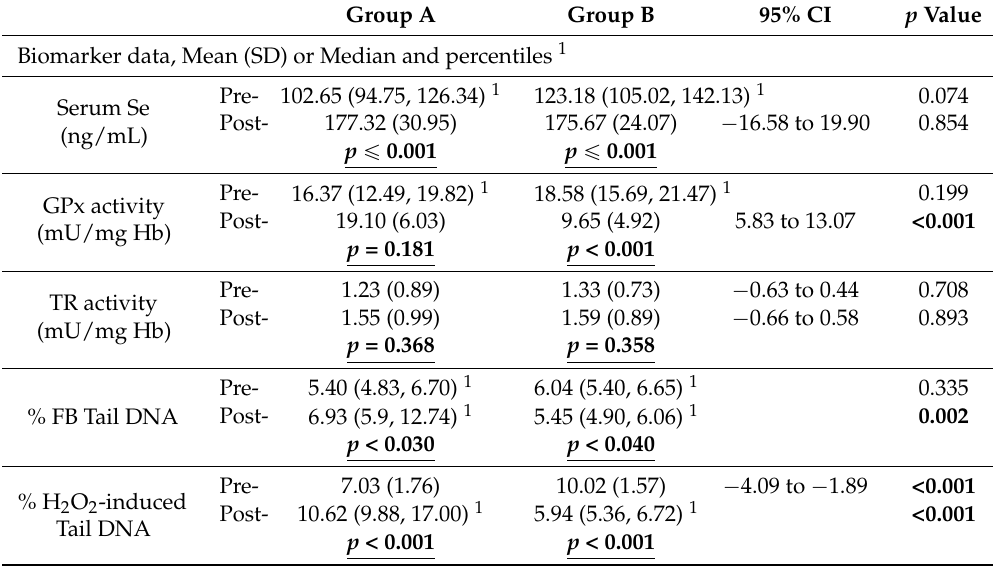
Table 3. Variation in pre-assessed biomarker data between subgroups A and B and between baseline and post-supplementation time points. Group A Group B 95%